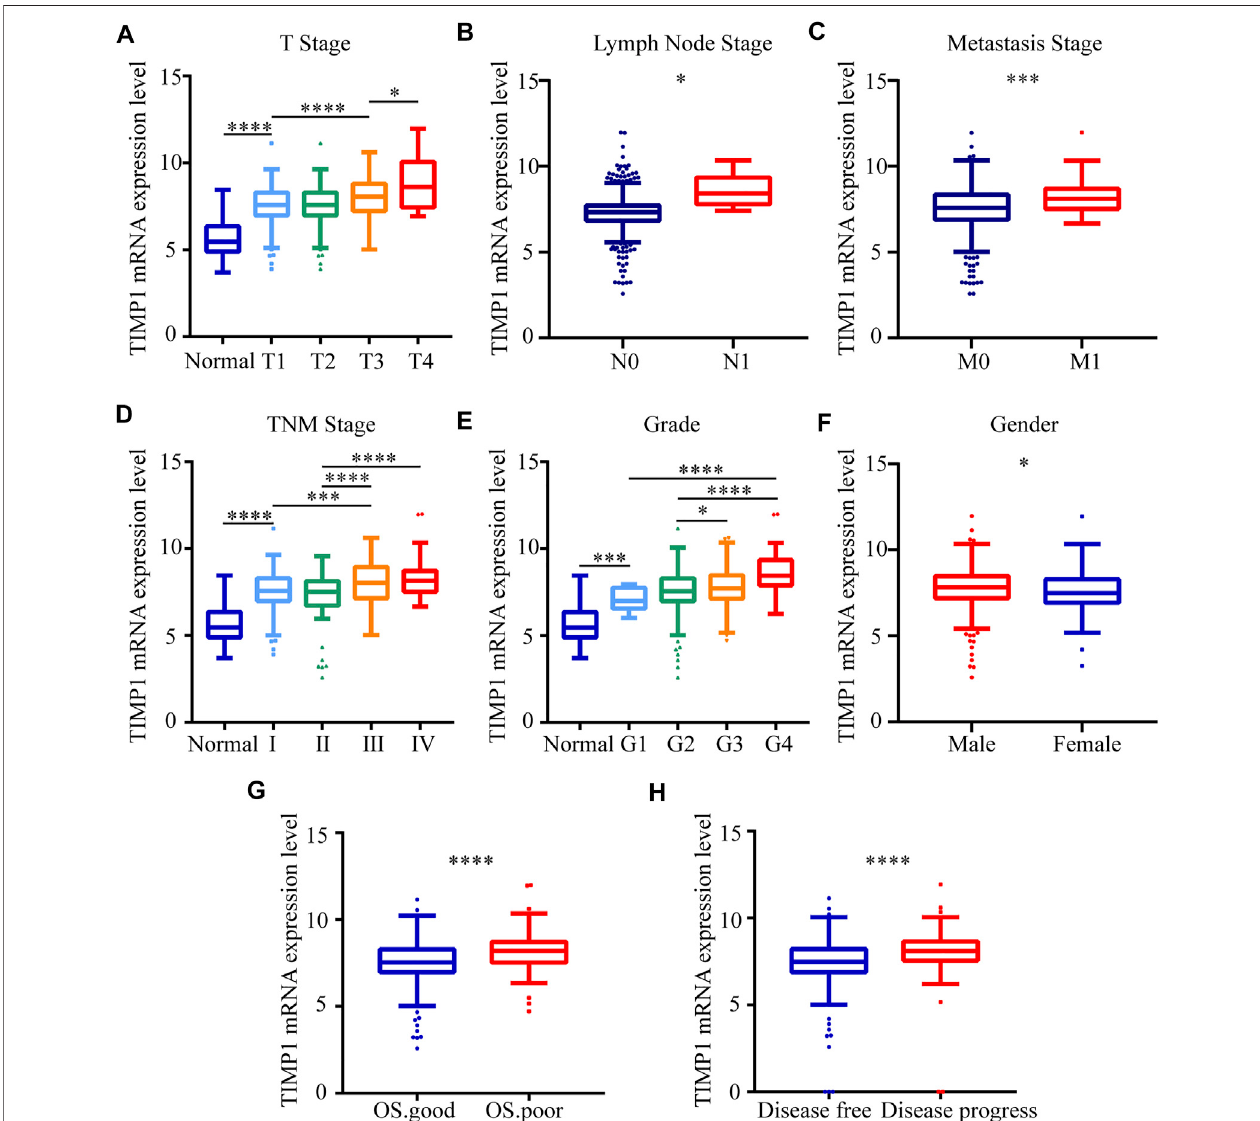
FIGURE 5 | TIMP1 expression level was associated with different clinicopathological parameters. The mRNA expression levels of TIMP1 were downloaded from the TCGA-KIRC database. TIMP1 was upregulated in (A) T stage, (B) lymph node metastasis, (C) distant metastases, (D) TNM stage, (E) G grade, (F) gender, (G) OS status, (H) DFSstatus.**** p < 0.0001;*** p < 0.001;* p < 0.05.TIMP1,Tissueinhibitormatrixmetalloproteinase1;RCC,clearcellrenalcellcarcinoma;KIRC,kidneyrenal clear cell carcinoma; TCGA, The Cancer Genome Atlas; TNM, Tumor-Node-Metastasis; OS, overall survival; DFS, disease-free survival.